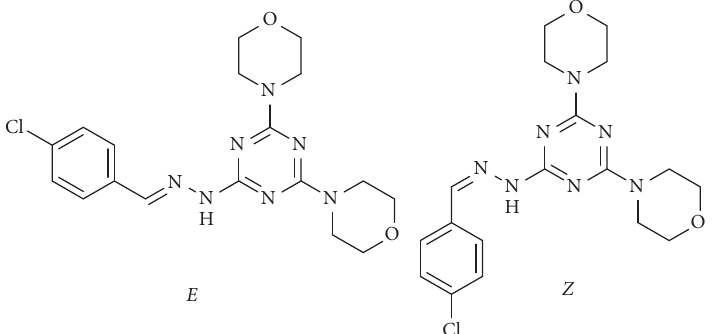
Scheme 4: E - and Z -isomer of compound 7k